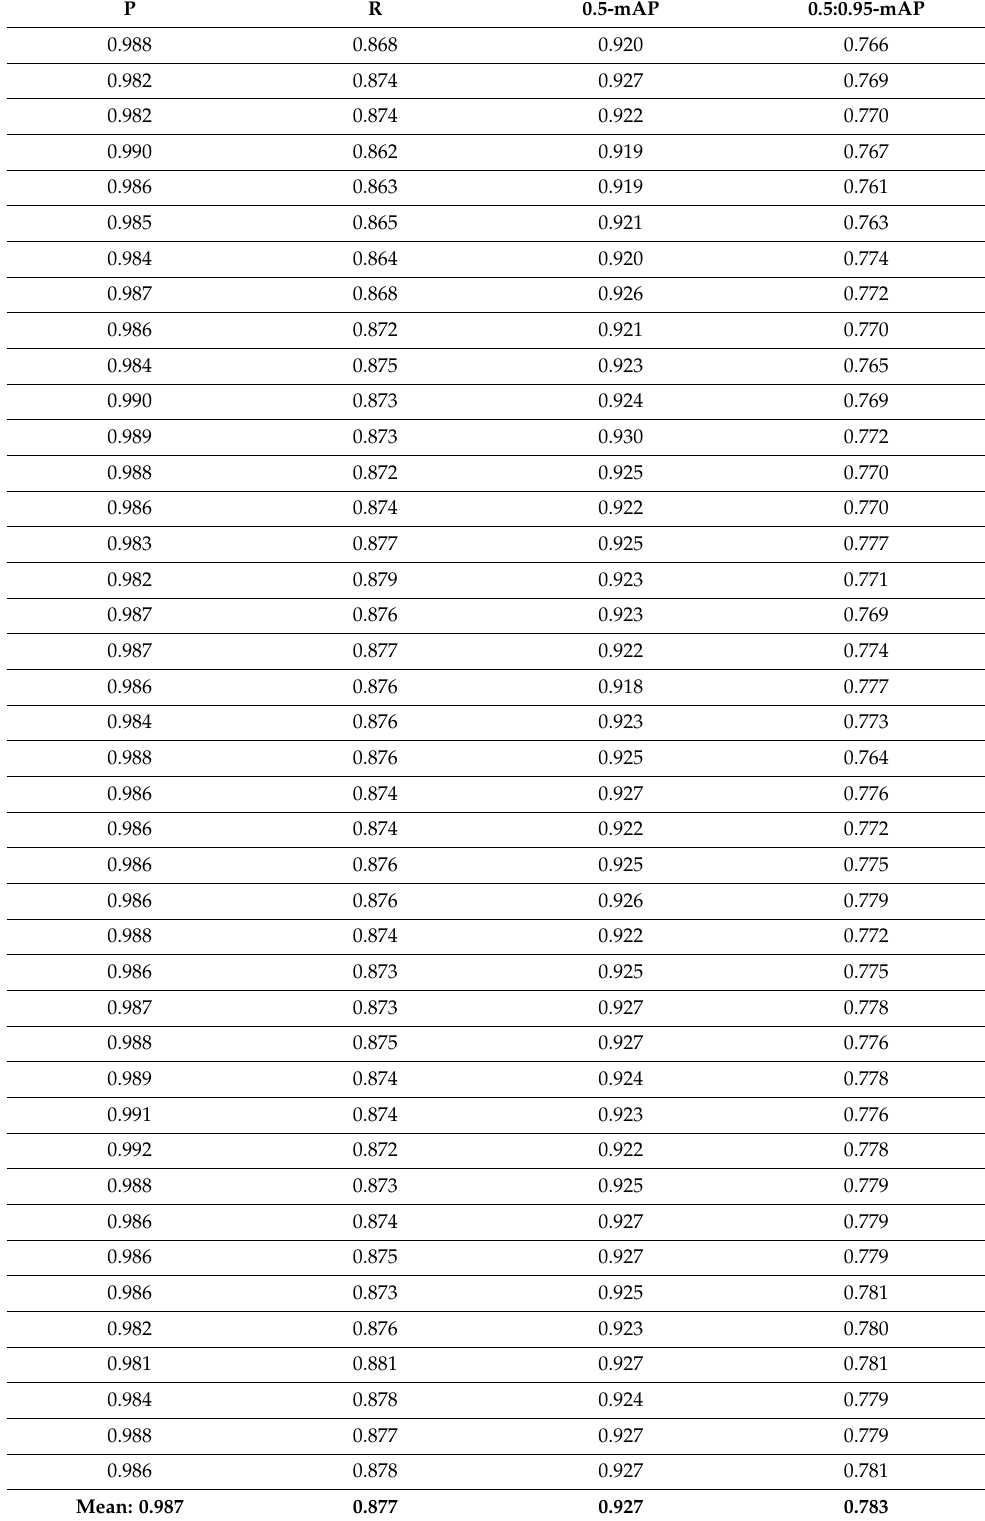
Table 4. Proposed method localization